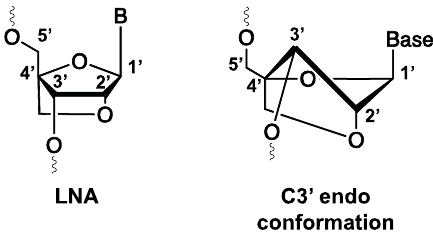
Figure 12. Structure of LNA (left) and the C3 (cid:48) endo conformation (right).